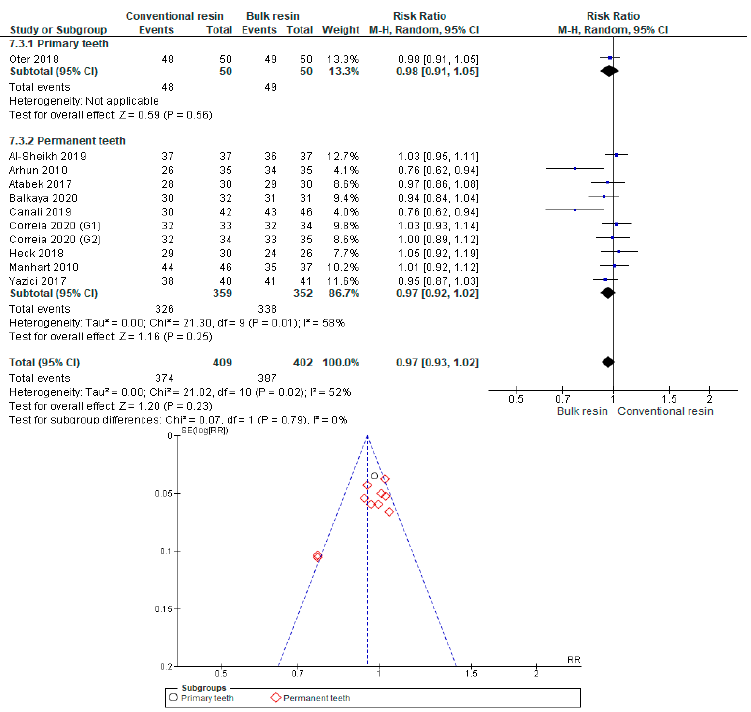
Figure A33. Proper Surface Texture: Conventional Resin versus Bulk Resin According to Type of Teething.